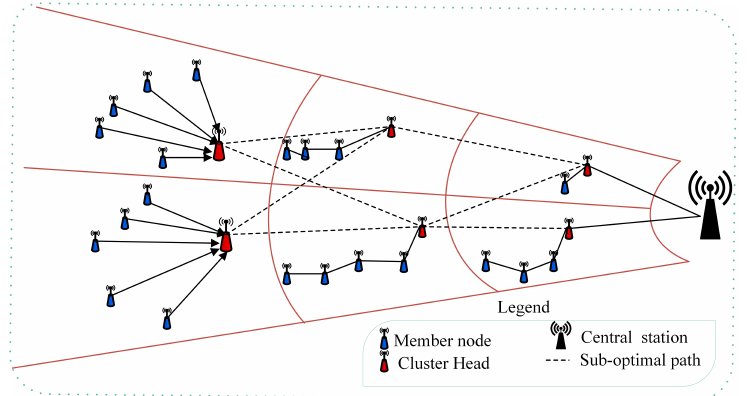
Figure 1. Overview of the proposed MIMO-HC